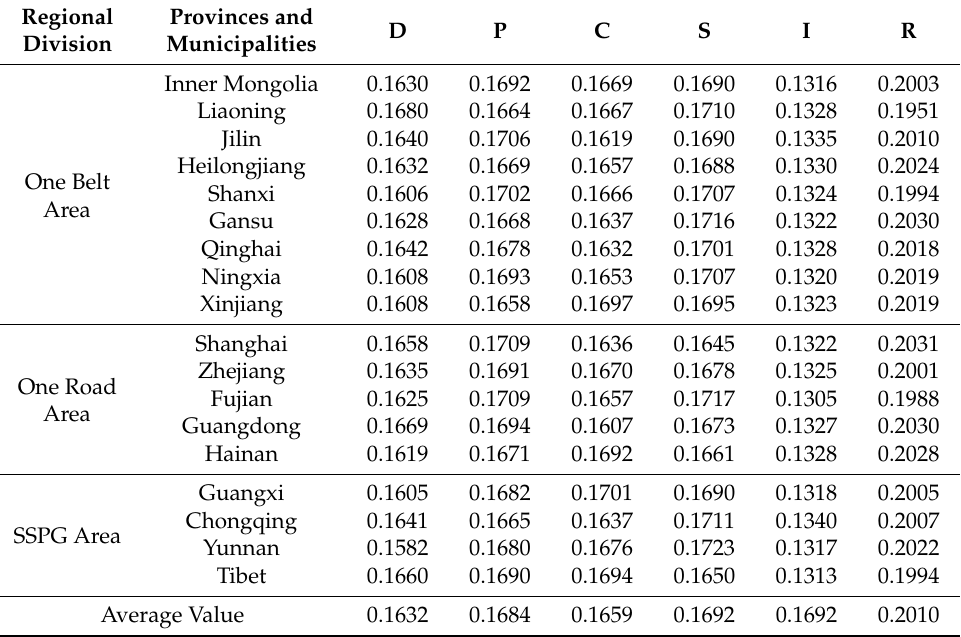
Table A1. The impact coefficient of DPCSIR subsystems on water security in the One Belt and One Road region of China from 2011 to 2016.